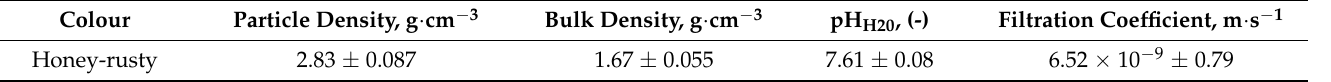
Figure 2. X-ray diffraction analysis of the waste dolomite. Table 3 shows the selected properties of the waste dolomite. The significant presence of iron compounds in the material (Table 1), especially in their hydrated form, causes a rusty-honey coloration of the dolomite post-floatation waste. The specific and bulk density values determined in the study do not differ from those obtained for this type of waste by other authors [53,54], which were 2.78–2.89 g · cm − 3 and 1.43–1.78 g · cm − 3 , respectively. consistent with the chemical properties of this material. Table 3. Selected physicochemical properties of waste dolomite. Particle Density, g · cm −